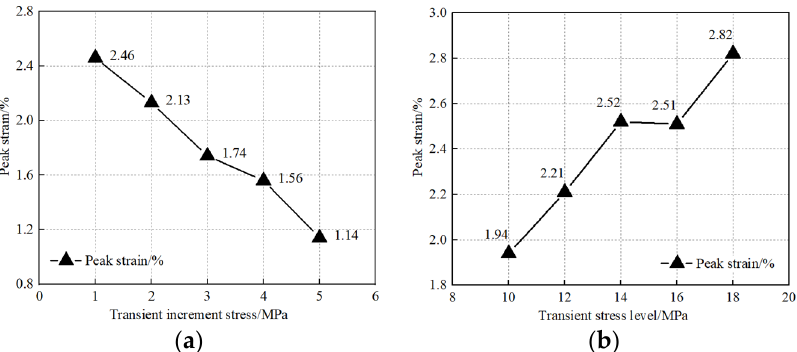
Figure 10. Relationship of cyclic stress control variables and peak strain: ( a ) cyclic amplitude; ( b ) cyclic frequency.